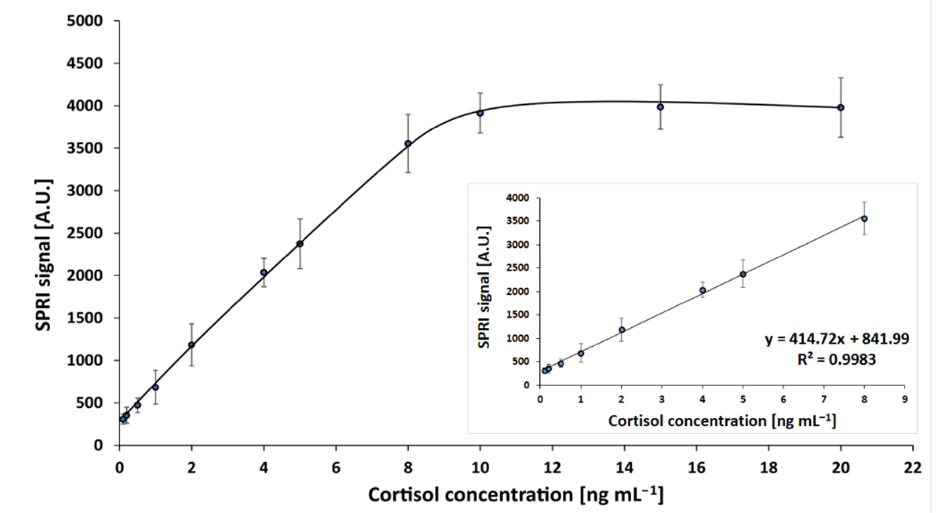
Figure 2. Dependence of the SPRi signal (arbitrary units) on cortisol concentration. Linear ranges are shown in an inset. The antibody concentration is 50 ng mL − 1 , and the pH of the cortisol solution is 7.4.